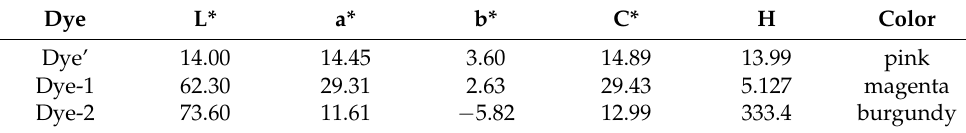
Table 2. Color data and CIE coordinates of the dyes on